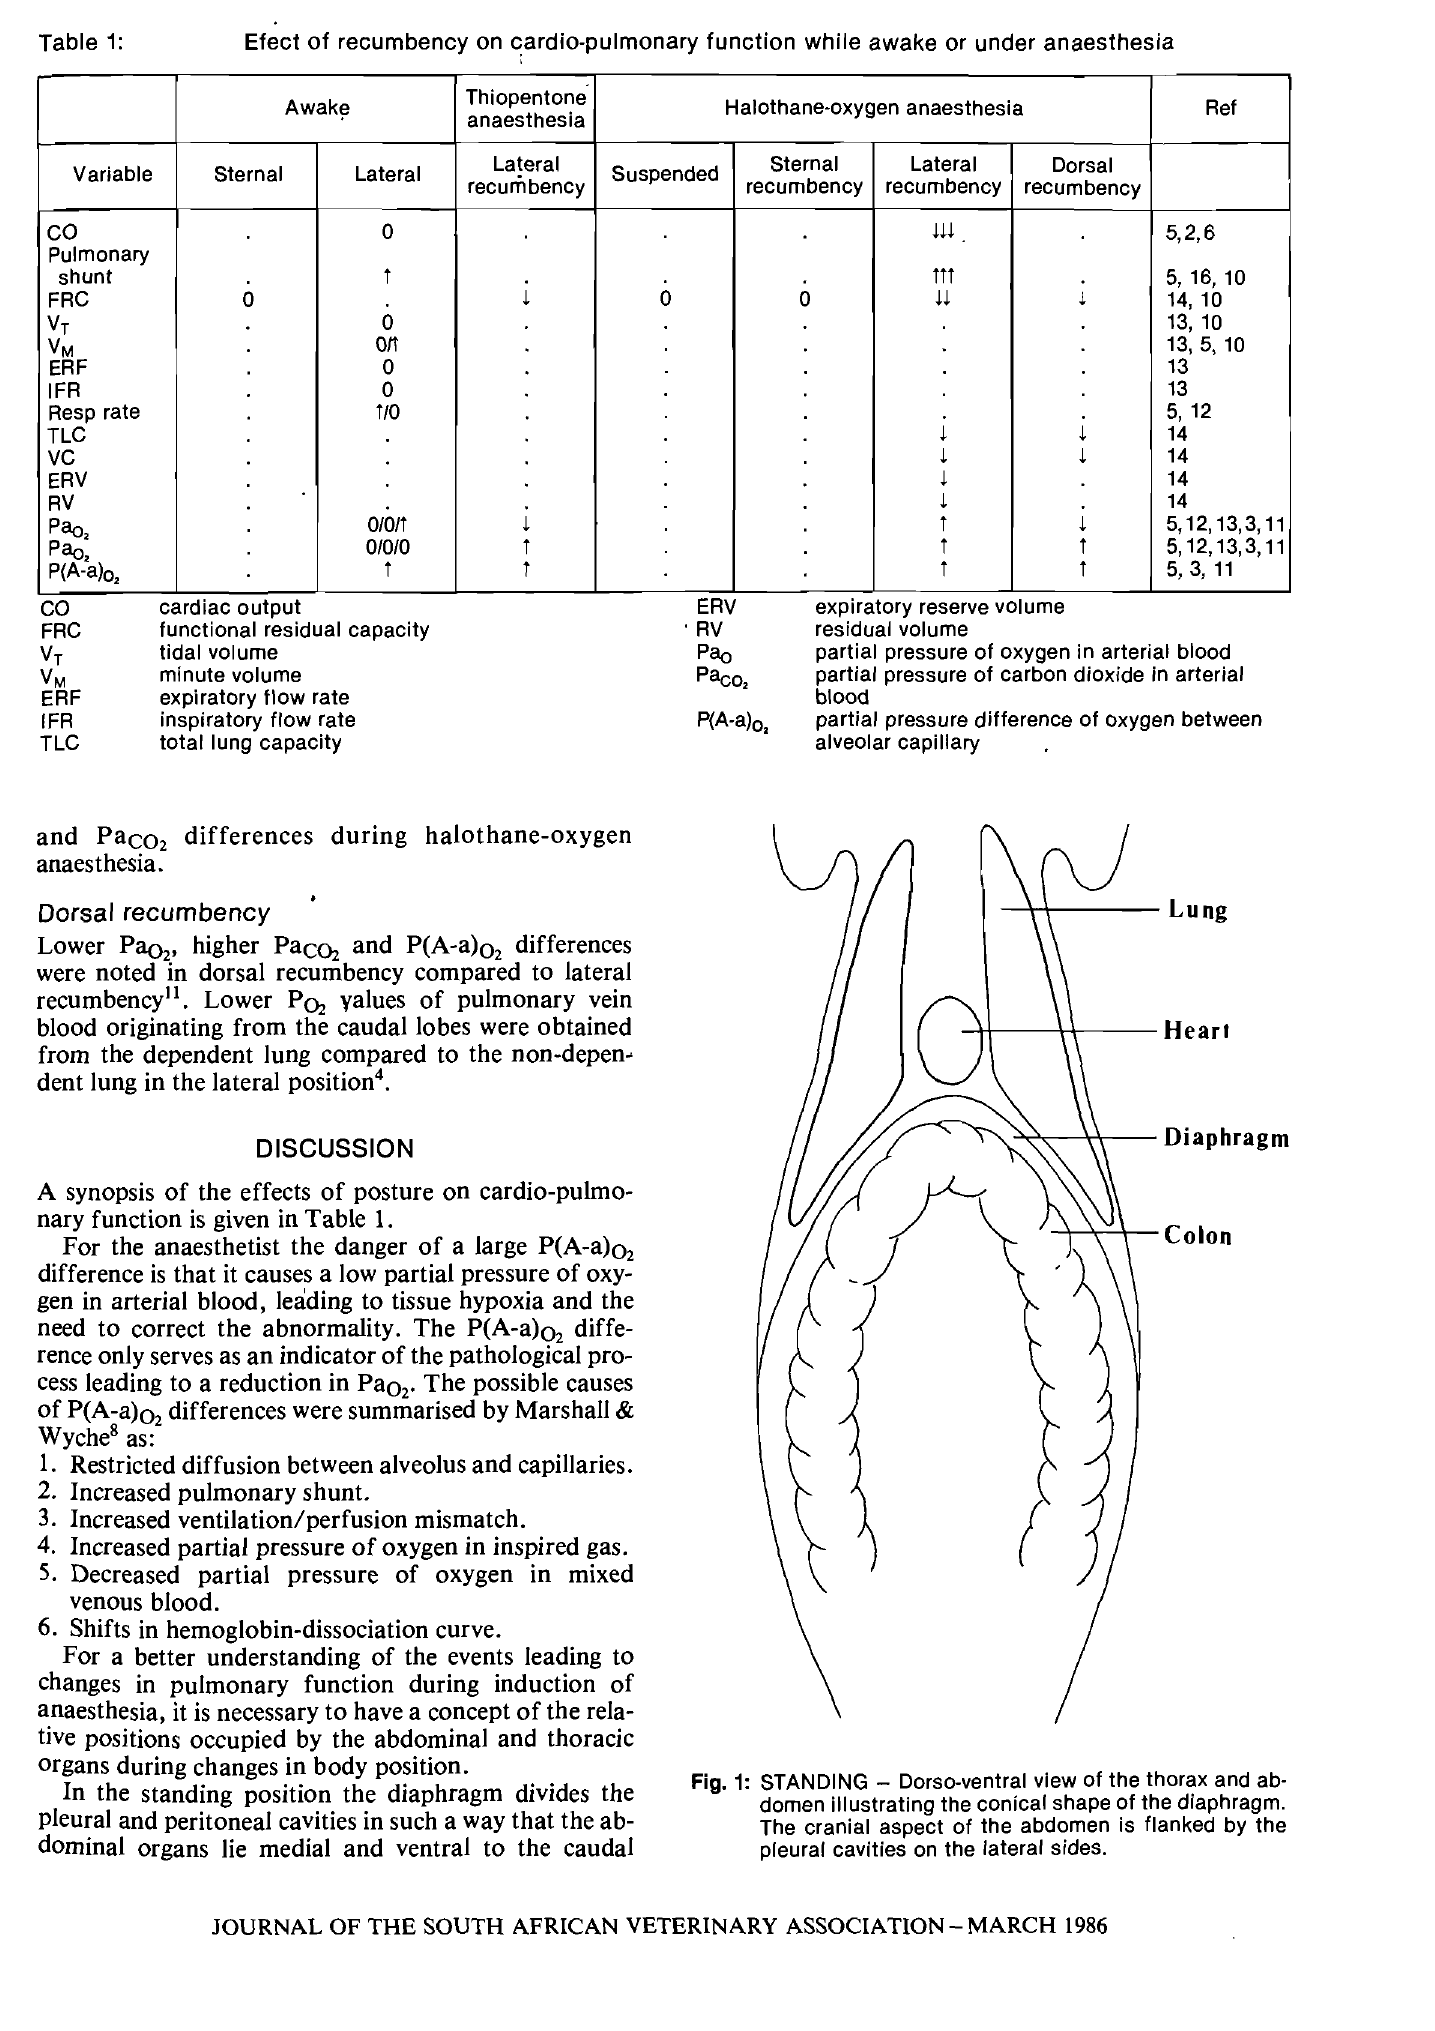
Efect of recumbency on ~ardio-pulmonary function while awake or under anaesthesia Awak~